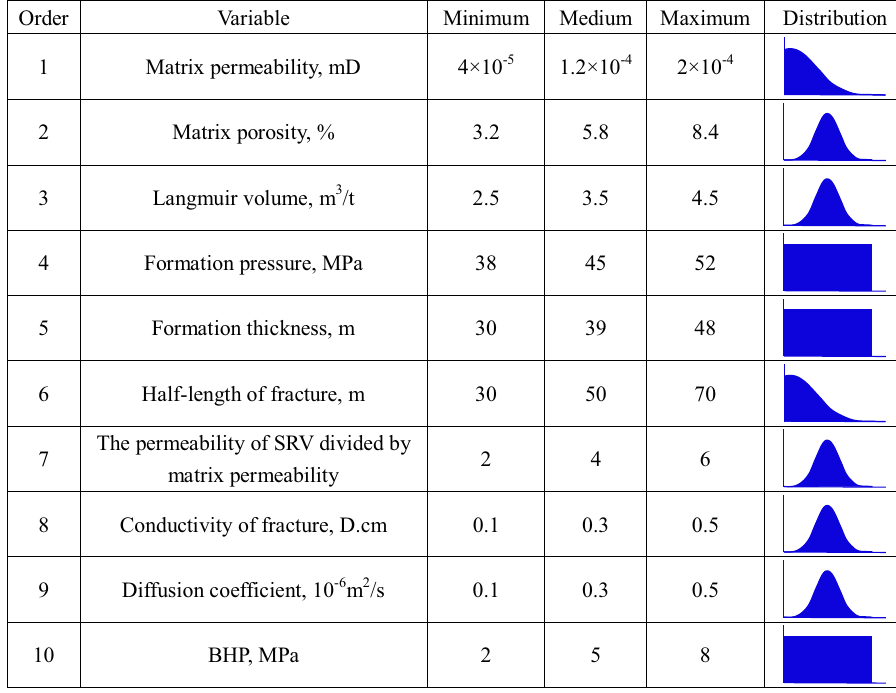
Table 2 List of input parameters selected for study and the distributions